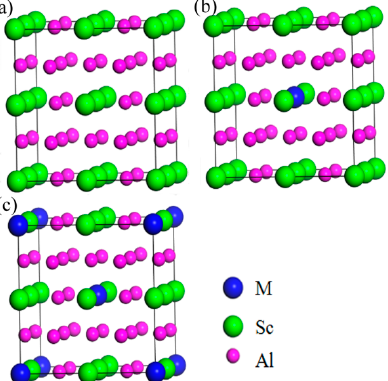
Figure 1. Structures of Al 3 Sc ( a ) 2 × 2 × 2 surpercell; doped with the alloying element (M = Sc, Zr, Ti, Y, Li) at different doping concentrations, ( b ) 3.125%, and ( c ) 6.25%. Blue, green, and pink balls represent (M = Zr / Ti / Y / Li), Sc, and Al atoms,